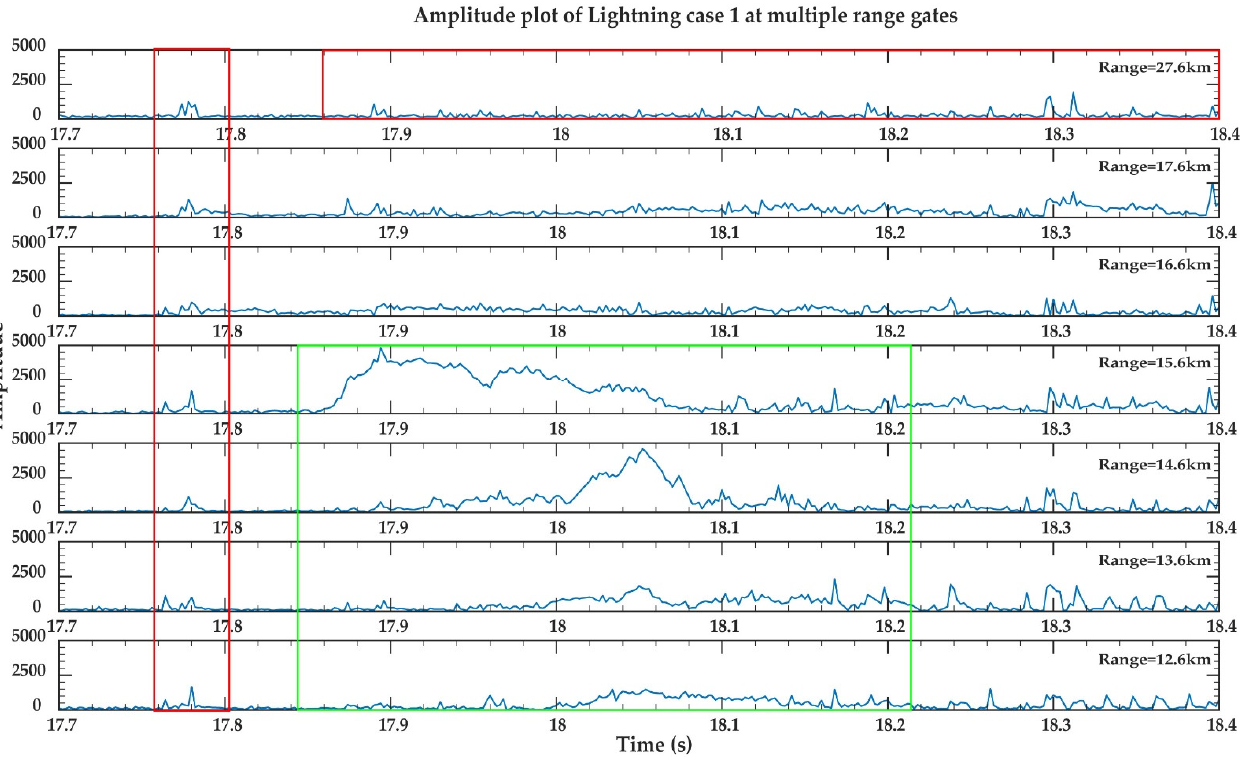
Figure 2. Amplitude of received lightning return echoes for multiple range gates ranging from 12.6 to 17.6 km at the interval of 1 km. The amplitude plot at a range gate 27.6 km is placed at the top for further explanation.